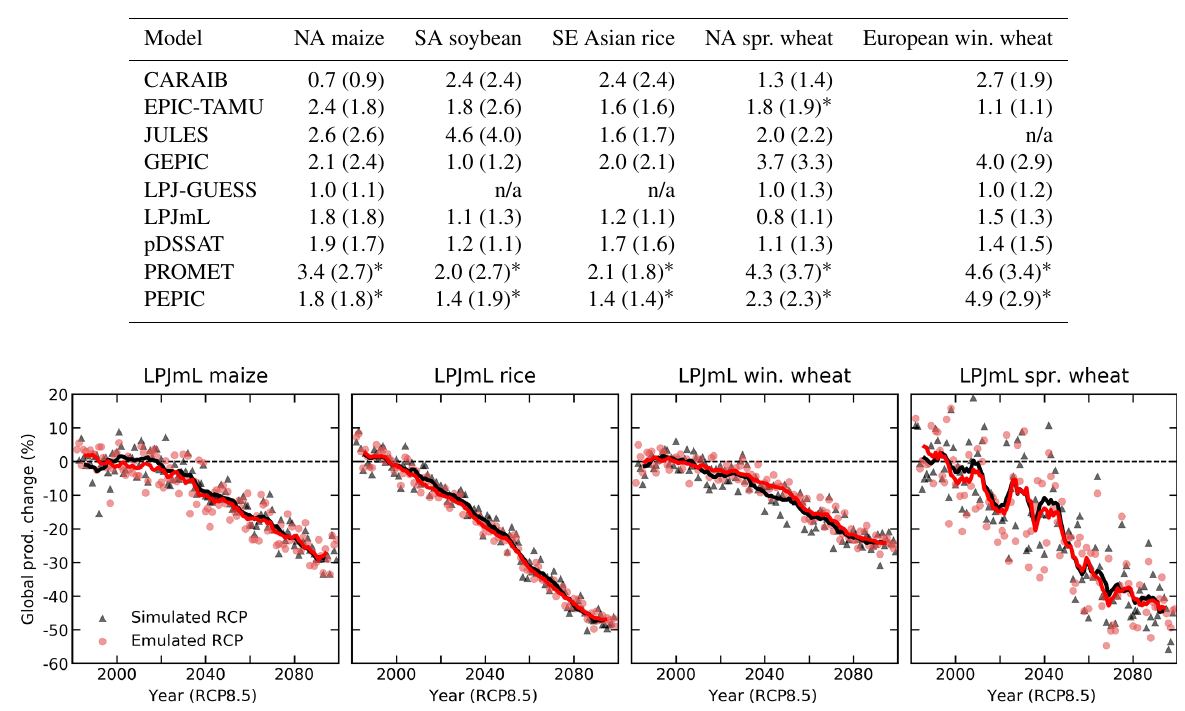
Table 3. RMSE of emulator replication of simulated yields of rainfed crops, stated as a percentage of simulated yield change. Values are the mean grid-cell error as a percentage of simulated yield change, over all currently cultivated grid cells weighted by cultivation area, for selected major regions (NA: North America, SA: South America). For comparison, global mean values are shown in parentheses. Errors are calculated using the 90–10 cross-validation scheme described in text, with the model trained on 90% of the data and validated on the held-out 10% (repeated twice). All fits are made with the Bayesian ridge method; for context, we mark with ∗ those cases where the Bayesian ridge is required because the OLS linear model fails (e.g., PEPIC, which has the lowest number of samples at n = 121). n/a – not applicable